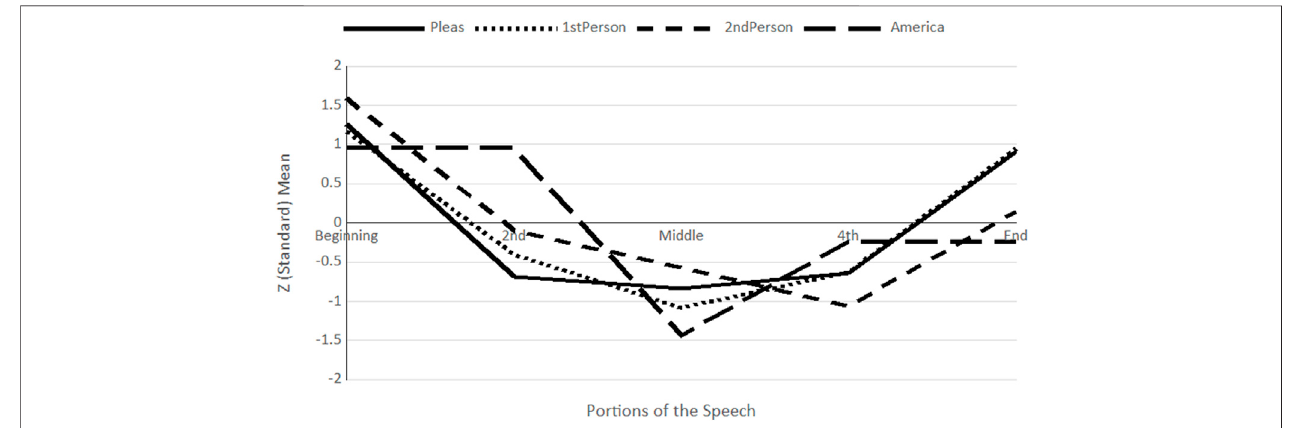
FIGURE 2 | The structure of speeches: changes across fi ve equal portions of speeches for pleasantness and the use of fi rst person and second person pronouns and America-words. Note: to allow for comparability, all means were plotted as standard (z) scores.